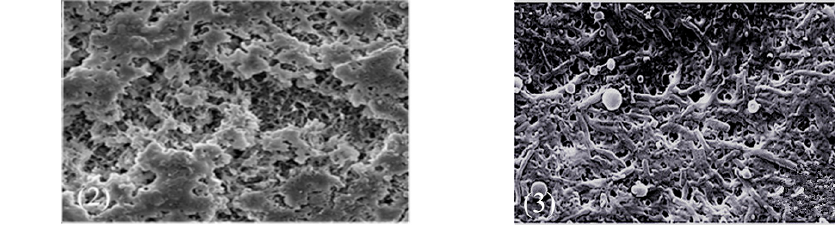
Figure 2. Fouling on membrane surface of MD: ( 1 ) inorganic fouling, ( 2 ) organic fouling, ( 3 ) biological fouling